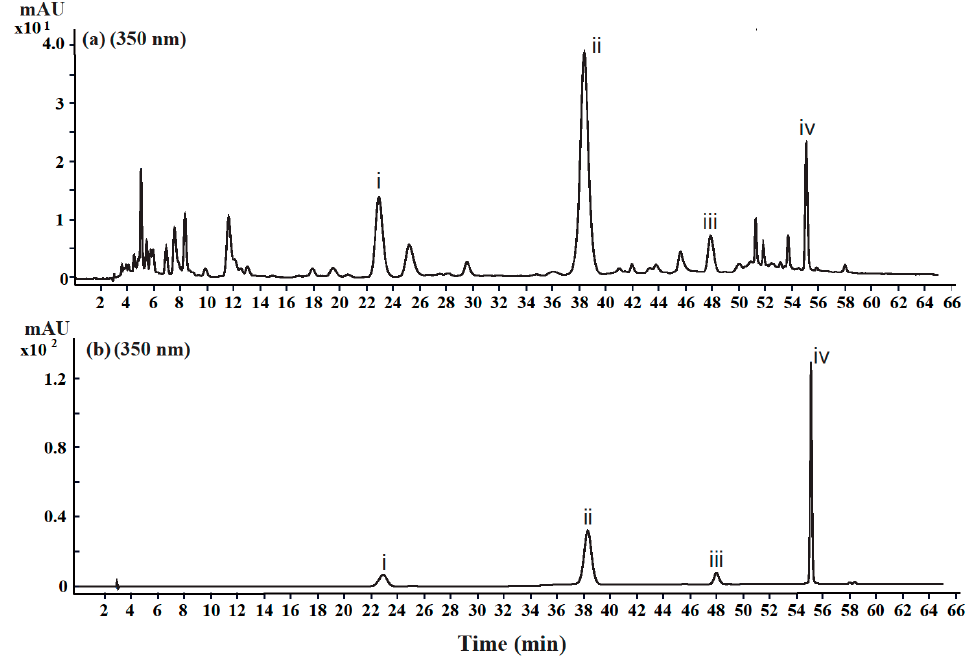
Figure 3. The chromatogram of the MJGT hydro extracts ( a ) and the mixed standards of the four flavonoids ( b ) detected at 350 nm. i: eriodictyol-7- O -glucoside; ii: luteolin-7- O -glucoside; iii: eriodictyol; iv: luteolin.